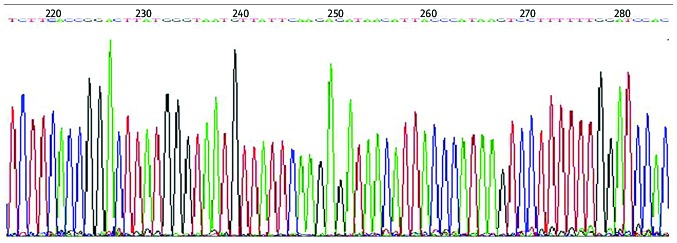
Sequencing chromatogram of the pGPU6-small hairpin RNA-cyclooxygenase-2 recombinant plasmid.